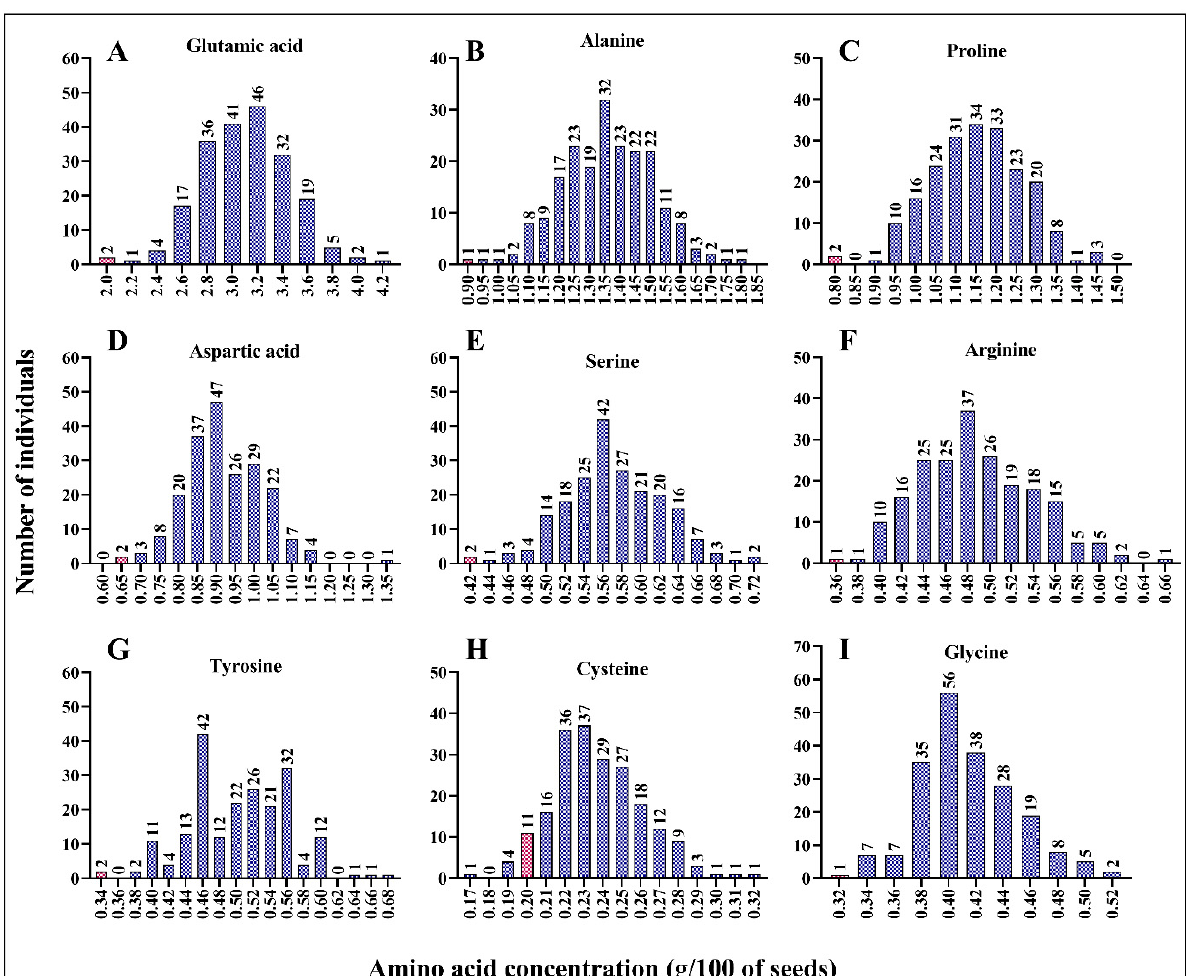
Figure 3. Mutant lines with various concentrations of the non-essential amino acids, glutamic acid ( A ), alanine ( B ), proline ( C ), aspartic acid ( D ), serine ( E ), arginine ( F ), tyrosine ( G ), cysteine ( H ), and glycine ( I ). The x value indicates g/100 g of dry seed sample. Total protein was extracted from 100 g of seeds and the amino acids were quantified. Control line (BTx623) is indicated by a red bar in each panel.